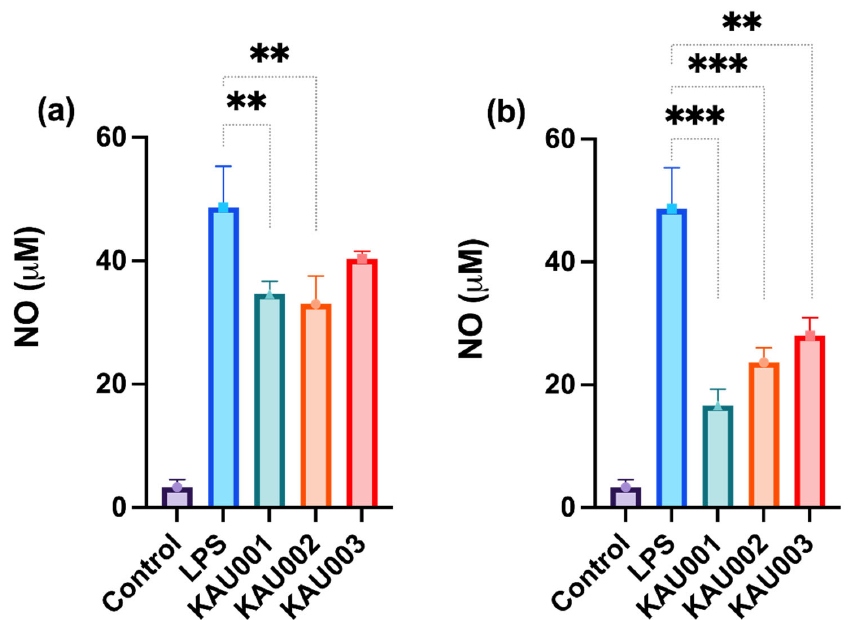
Figure 2. Effect of selected LAB strains on nitric oxide production in LPS-induced RAW 264.7 cells. ( a ) Treatment with 10 7 CFU/mL of LAB and 0.1 ug/mL of LPS. ( b ) Treatment with 10 8 CFU/mL of LAB and 0.1 ug/mL of LPS. Data are expressed as mean ± S.D. from three independent experiments. Bars with asterisks indicate significant differences as follows (** p < 0.005, *** p < 0.001). Bars with no asterisks depicts groups with no significance.